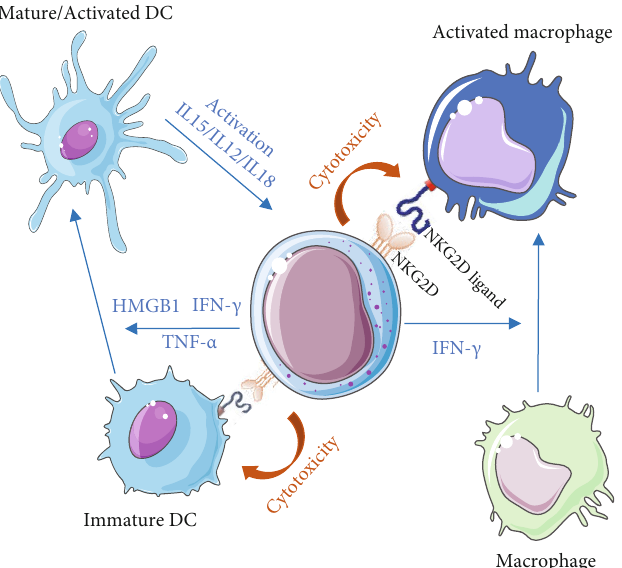
Figure 5: Crosstalk of NK cells with immature DC/activated DC and with resting or activated macrophages either by soluble mediators (blue arrows) or by direct receptor-mediated cell-cell interaction (orange